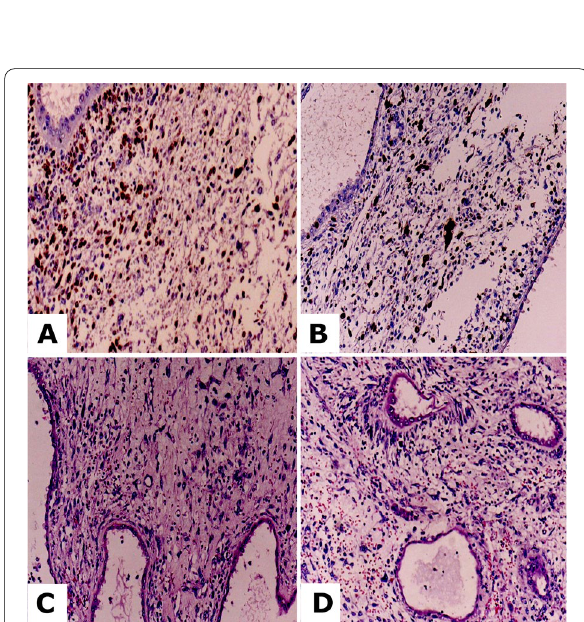
Fig. 5 A – D Hematoxylin and eosin staining reveals undifferentiated sarcoma of multinucleated and hyperchromatic cells embedded